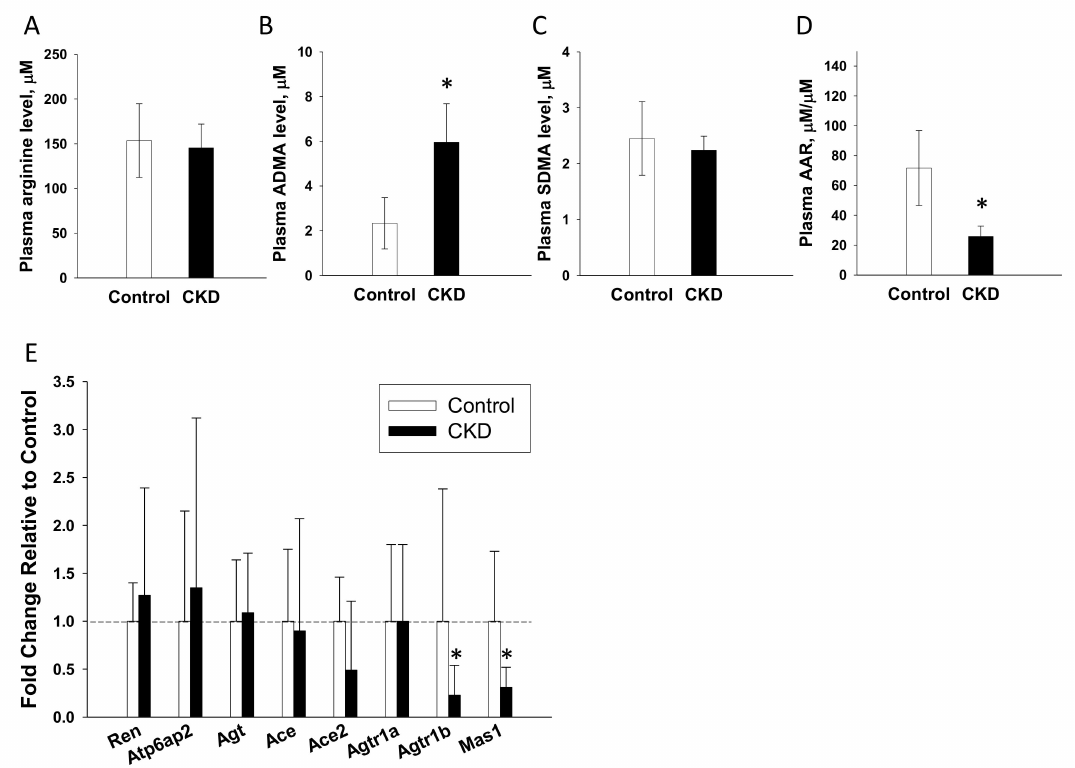
Figure 6. Nitric oxide (NO) system and renin-angiotensin system (RAS) in male o ff spring rats. ( A ) Plasma L-arginine level, ( B ) plasma asymmetric dimethylarginine (ADMA) level, ( C ) plasma symmetric dimethylarginine (SDMA) level, and ( D ) L-arginine-to-ADMA ratio (AAR) between the two groups. ( E ) Renal mRNA expression of the RAS components between the two groups. Control = male o ff spring born to dams fed with regular chow; CKD = male o ff spring born to dams received chow supplemented with 0.5% adenine for 3 weeks before pregnancy. Ren = renin; Atp6ap2 = prorenin receptor; Agt = angiotensinogen, Ace = angiotensin converting enzyme-1; Ace2 e = angiotensin converting enzyme-2; Agtr1a = angiotensin II type 1 receptor; Agtr1b = angiotensin II type 2 receptor, Mas1 = angiotensin (1–7) receptor. Data are shown as means ± SD; n = 8 / group. The asterisk indicates p < 0.05 vs.